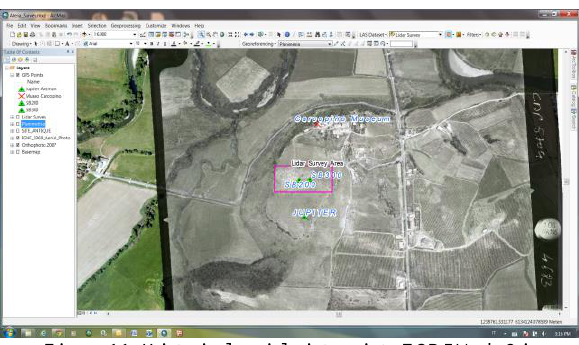
Figure 11. Historical aerial picture into ESRI Web